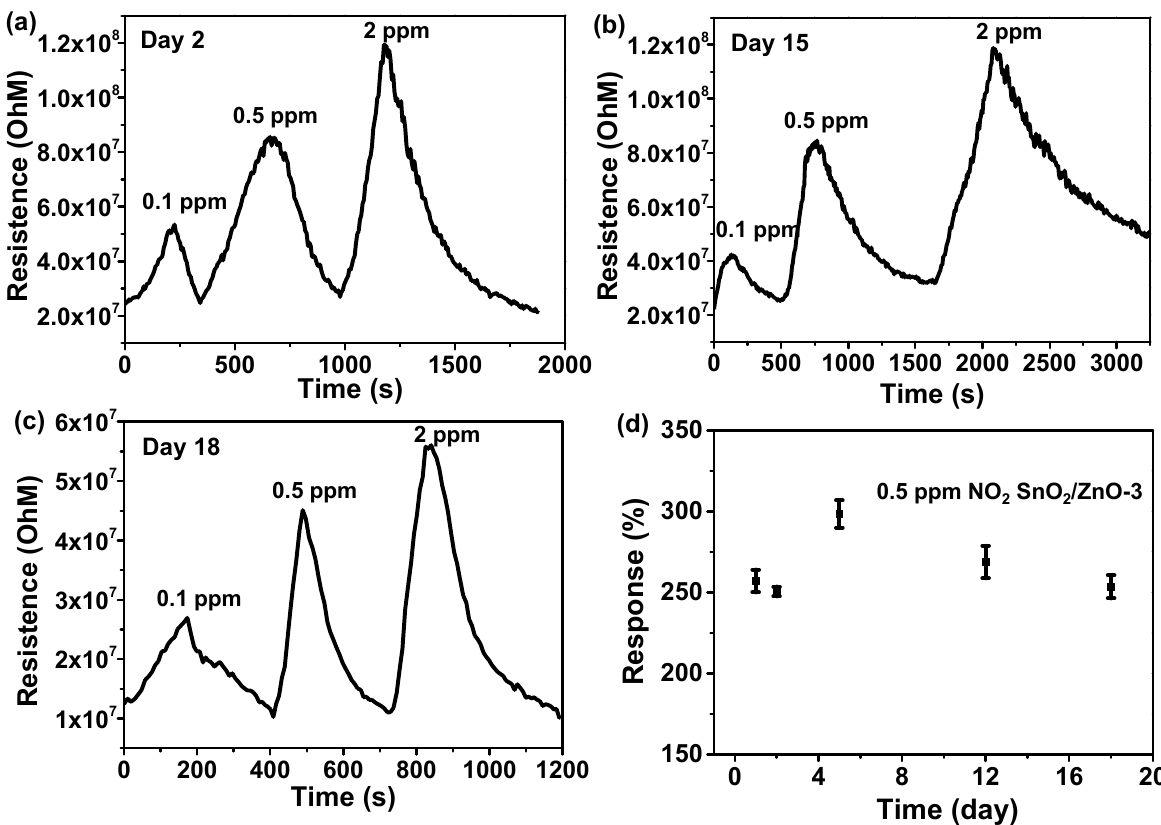
Figure 8. Resistance value of SnO 2 /ZnO-3 sensors to 0.1, 0.5, 2 ppm NO 2 gas on the ( a ) second day, ( b ) 15th day, ( c ) 18th day. ( d ) The stability of SnO 2 /ZnO-3 sensors to 0.1, 0.5, 2 ppm NO 2 gas within about 18 day.